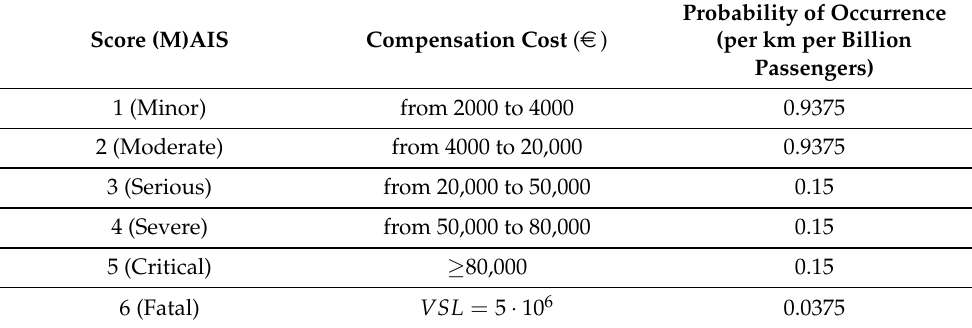
Table 4. Abbreviated injury scores with their corresponding compensation costs and probability of occurrence